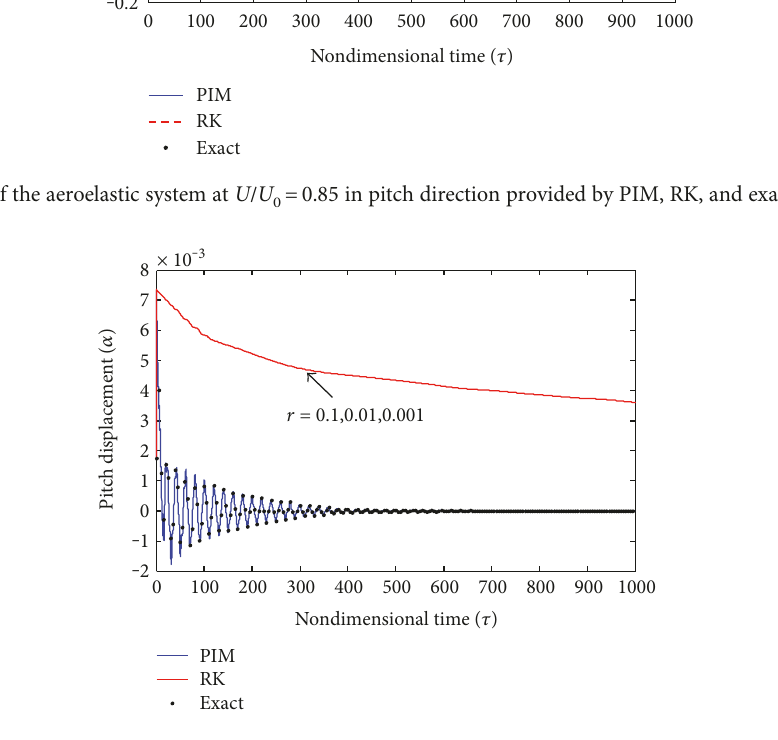
=0.1 obtained by the exact solutions, PIM with the time step as 0.1, and RK with 0